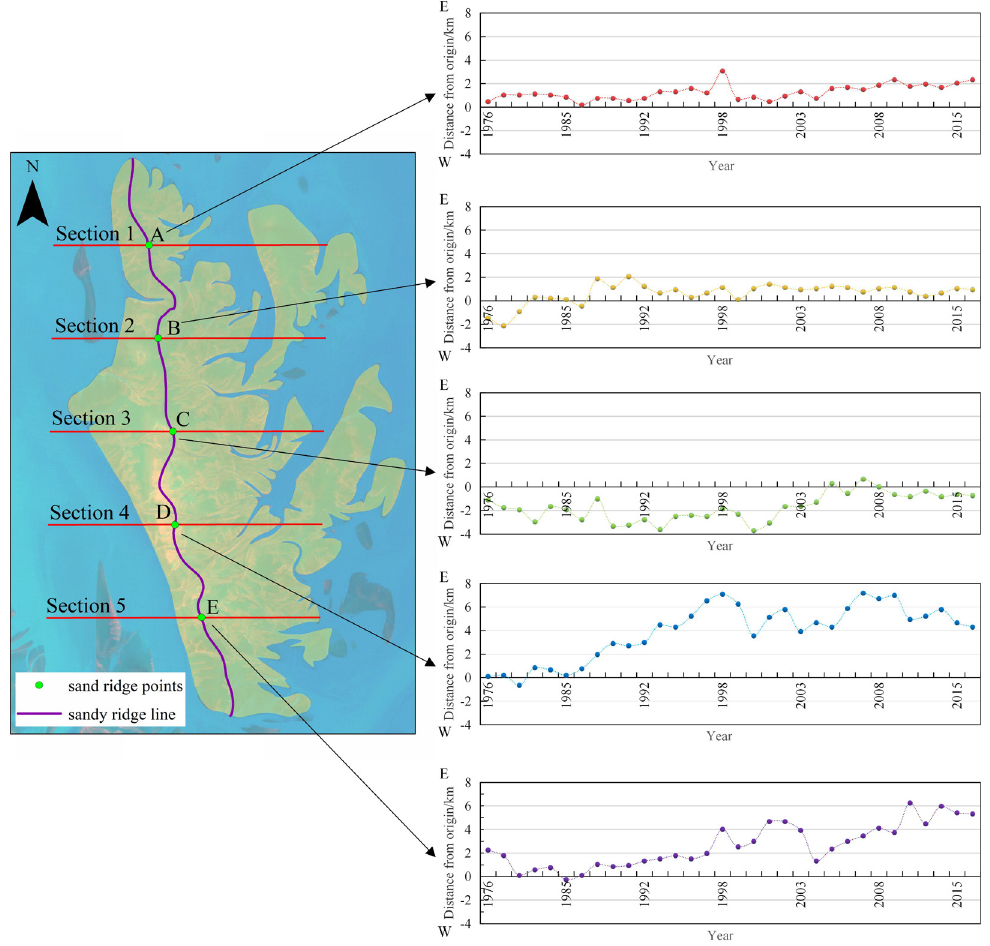
Figure 7. Location distribution of sand ridge points in different periods.